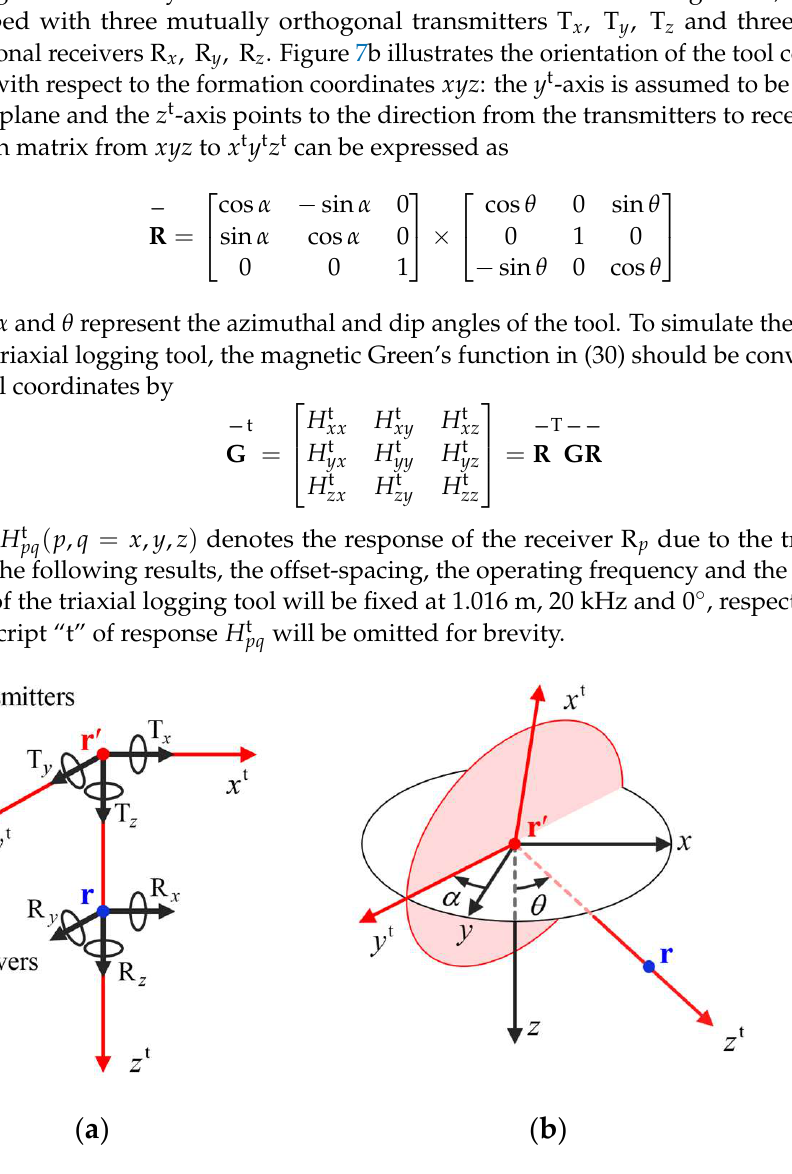
Figure 8. Five-layer anisotropic model and two deviated well logging trajectories in the formation coordinates xyz . Layers 2 and 4 share the same tensor conductivity σ . 3.1. Triaxial Logging Responses in Layered TI Media To validate this new algorithm, we compare the results by the present FRA with those of the TLM [30] in a TI formation. The five-layer model in Figure 8 is considered, where the conductivity σ of layers 2 and 4 is assumed to be TI and is equal to diag(1,1,0.1) S/m . Two different tool dip angles